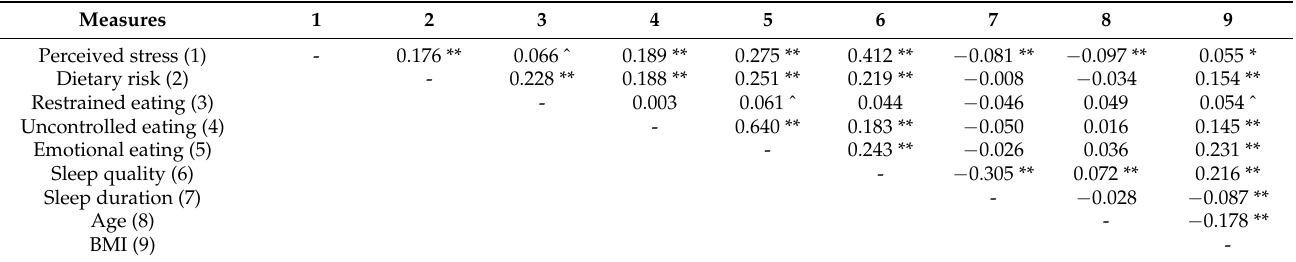
Table 3. Zero order correlation of variables and covariates examined in the mediation/moderation models.